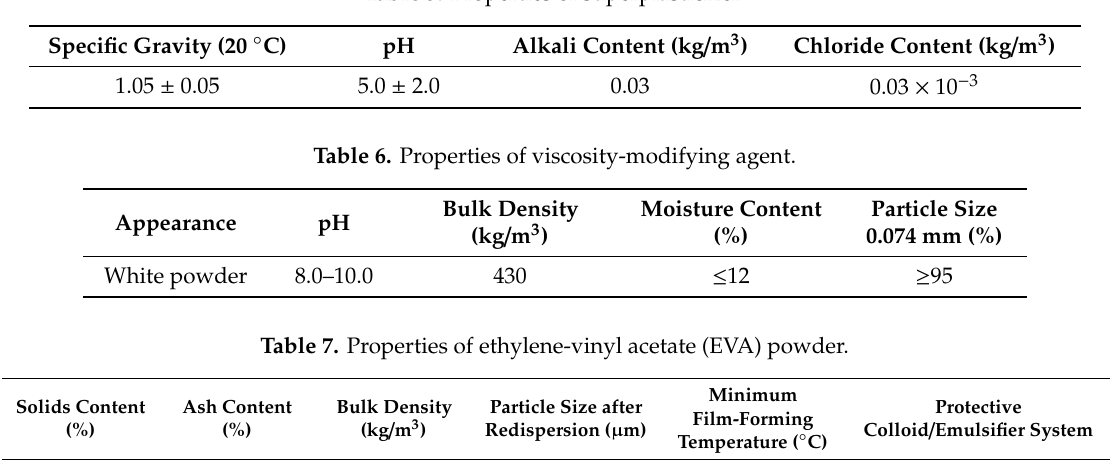
Table 5. Properties of superplasticizer.